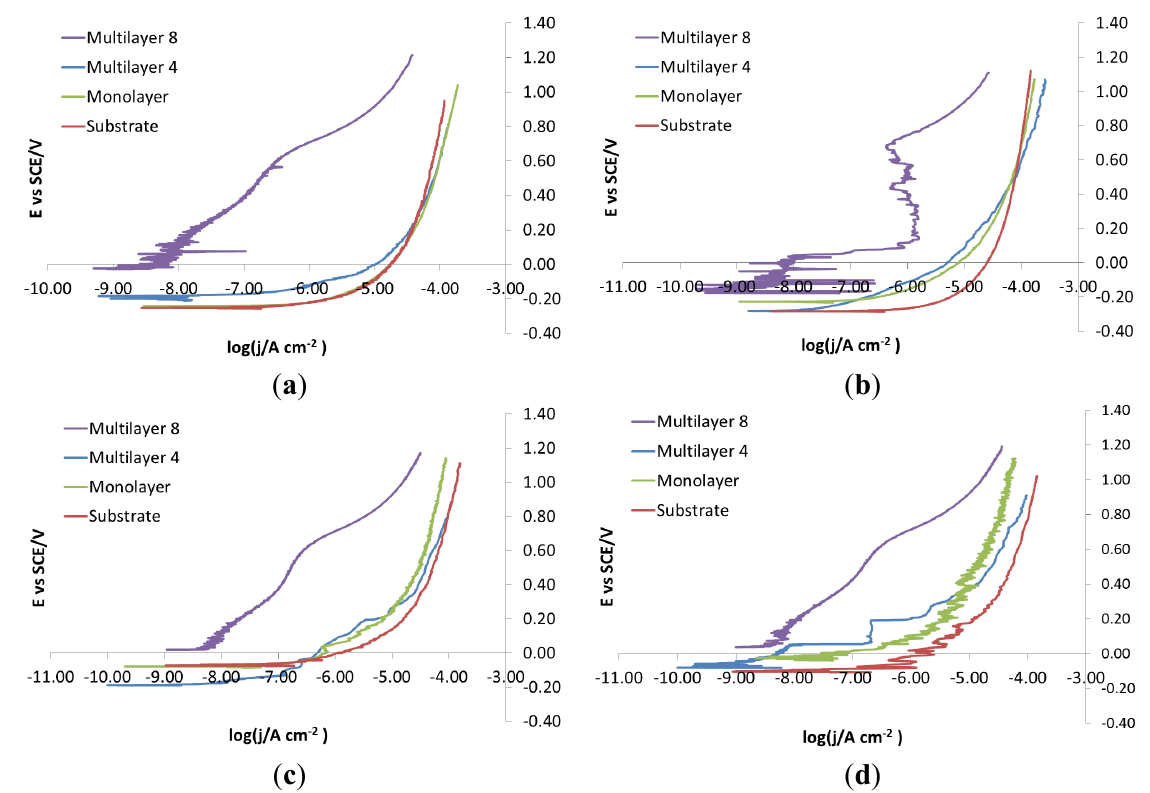
Figure 9. Ground finish: polarization curves on bare and coated steels. ( a )